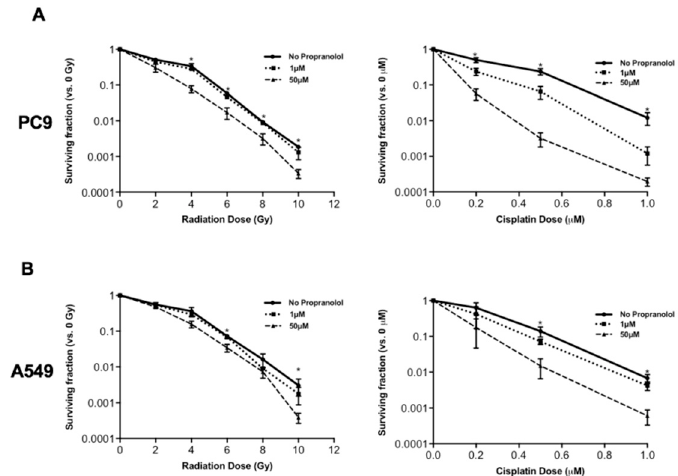
Figure 1. Dose-survival curves of PC9 ( A ) and A549 ( B ) cells treated with varying cisplatin and radiation doses with or without propranolol. Propranolol was administered at 0, 1, or 50 micromolar ( µ M) to PC9 and A459 cells immediately before cisplatin exposure or irradiation (gray (Gy)). In clonogenic survival assays, propranolol (50 µ M) significantly sensitizes tumor cells to cisplatin and radiation when compared to untreated (no propranolol) cells. * p <0.05.